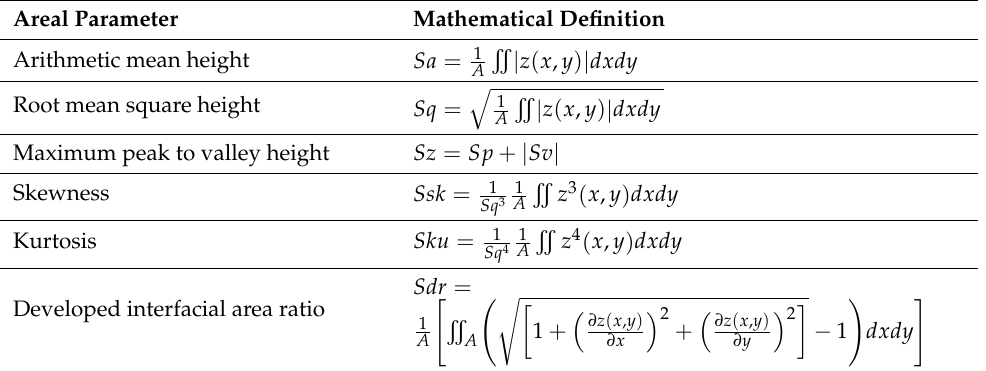
Table 3. Description of the selected areal